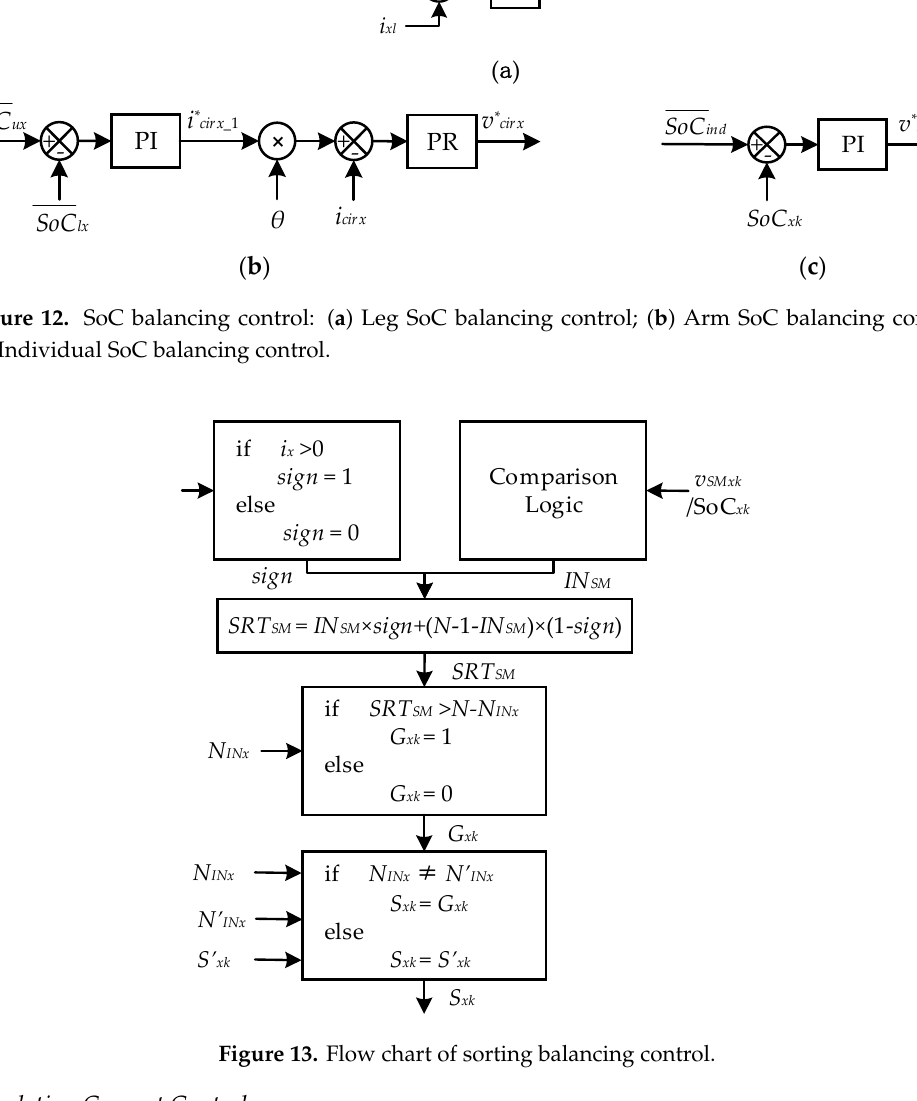
Figure 13. Flow chart of sorting balancing control.